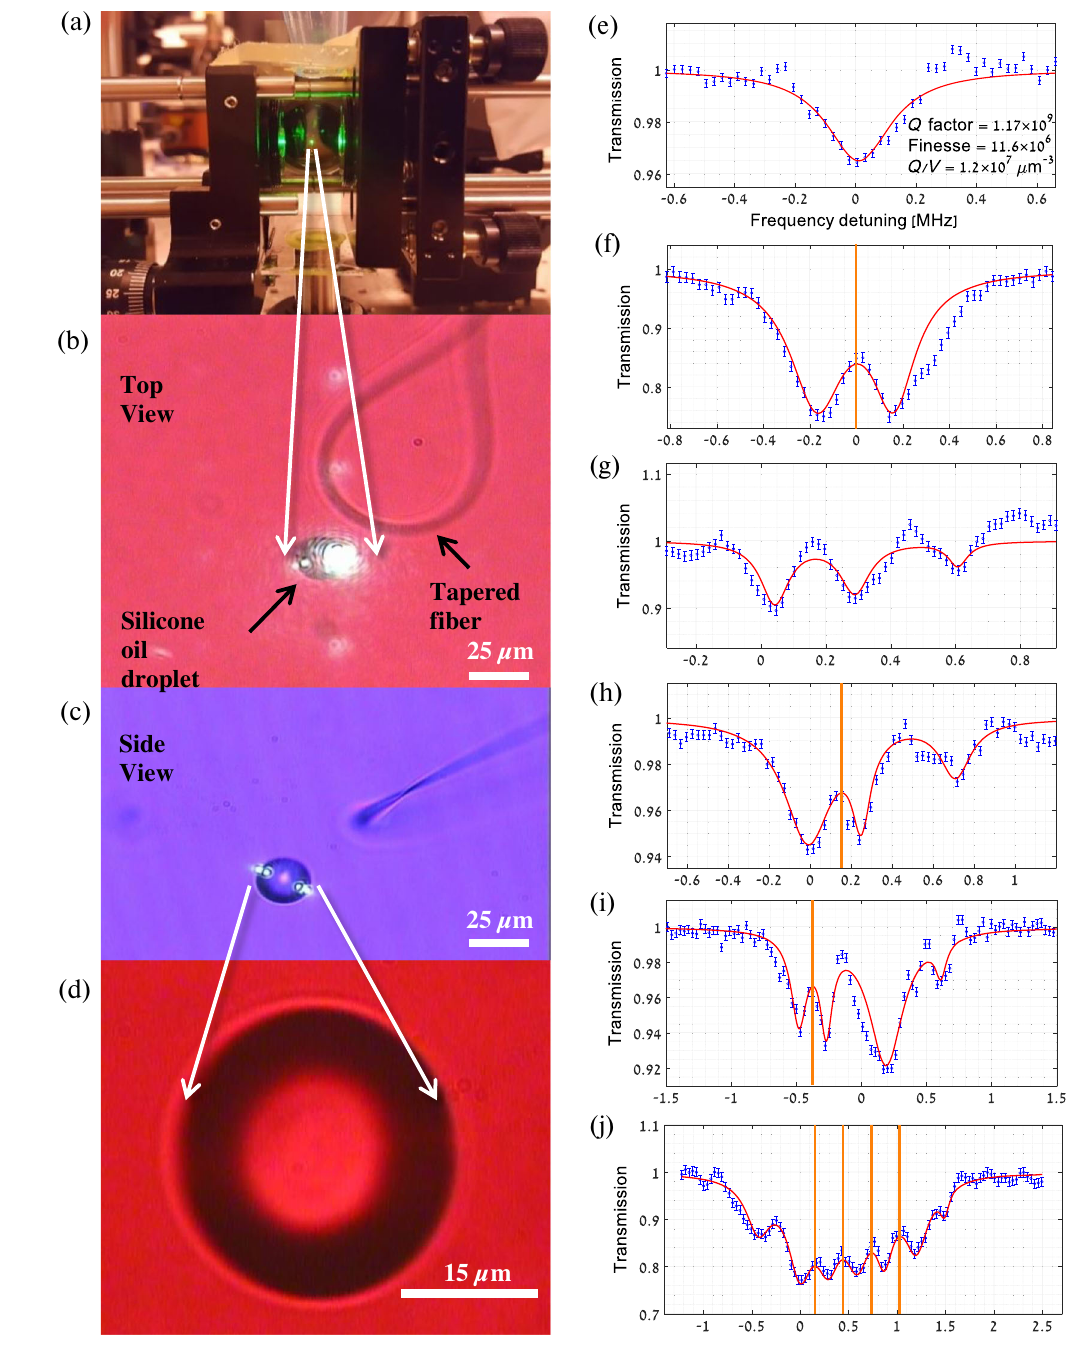
FIG. 3. A photograph of the experiment. (a) The levitating microdroplet is visible to the naked eye via scattering of the tweezers ’ green light. Micrographs of the experiment where we present top (b), side (c), and enlarged (d) views of the resonator-taper region. (e) – (j) Experimental results with 1 – 7 adjacent resonances (blue) together with a fit to a several-Lorentzians model (red). Resonances at (e) – (j) were measured at different spectral regions. The error bar represents the standard deviation. Orange lines represent regions of coresonating (partially overlapping) mode. λ ¼ 980 nm, r ¼ 11 . 45 μ m for (d), (h), and (i), and 13 . 5 μ m for (f), (g), and (j), and n ¼ 1 . 4 . Deviations of the measured transmission from the Lorentzian model relate to the nonperfectly uniform scanning rate of the tunable